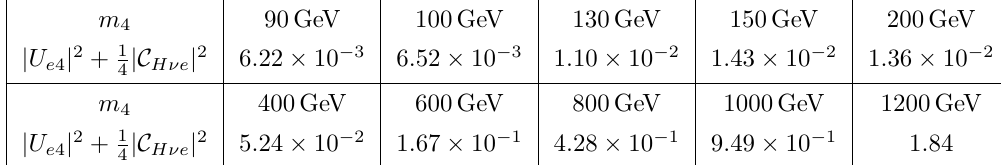
Table 4 . Same as table 3 but for the e -flavor channel and based on search of ref.